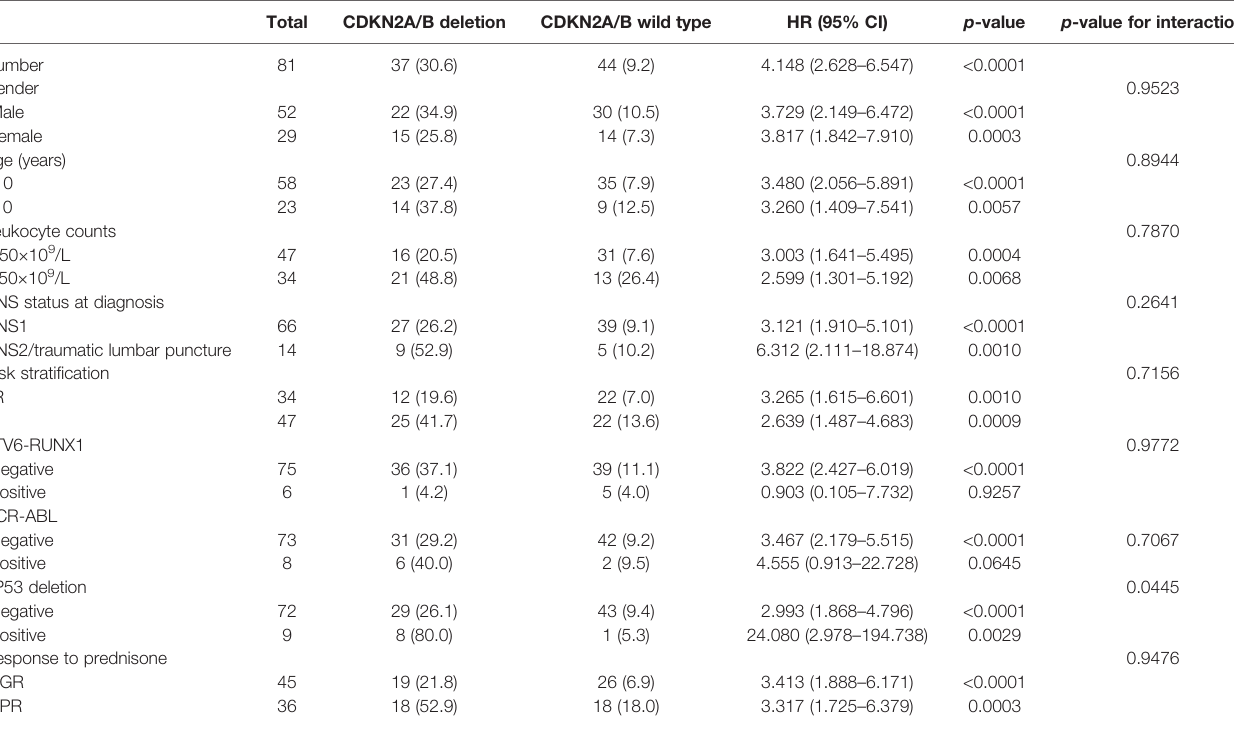
TABLE 3 | Hazard ratio for event-free survival in prespeci fi ed subgroup.